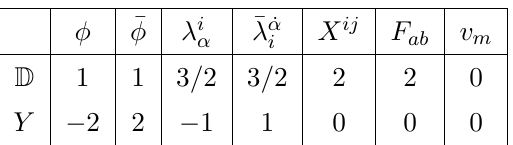
Table 4 . Summary of the dilatation and chiral weights in the off-shell Abelian vector multiplet.